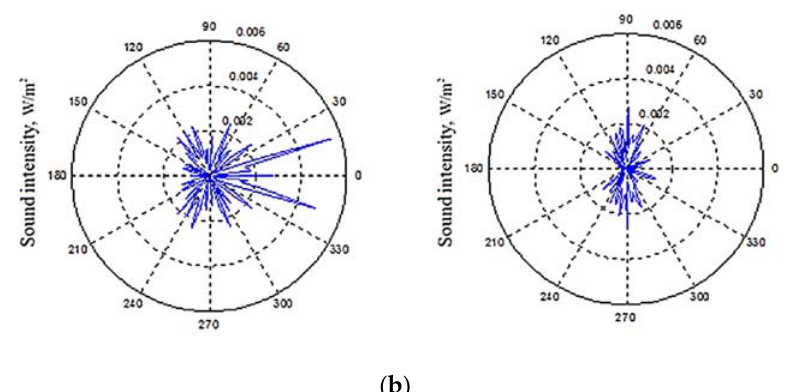
Figure 20. The intensity polar pattern diagram of the uncloaked (left side) and cloaked objects (right side) with incident wave frequency f = 1000 Hz: ( a ) the intensity polar pattern of the total sound field; ( b ) the intensity polar pattern diagram of the normalized sound field (scattered field of the object).